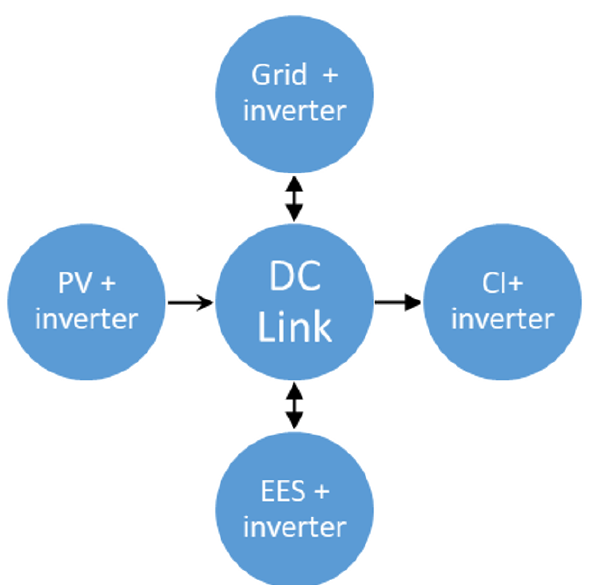
Figure 3. Proposed system for charging infrastructure with a renewable energy